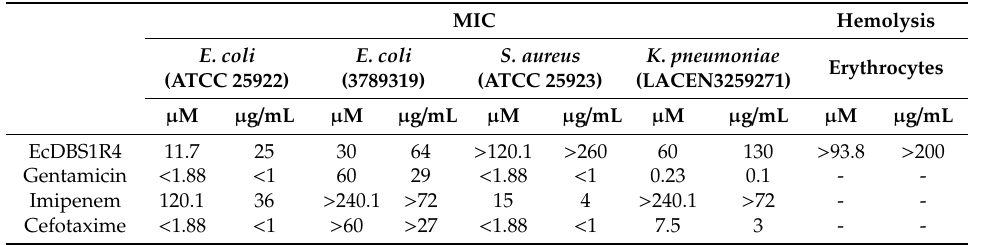
Table 1. EcDBS1R4 minimal inhibitory concentrations (MIC) calculated for di ff erent bacteria strains, as well as erythrocyte hemolysis compared with commercial antibiotics.